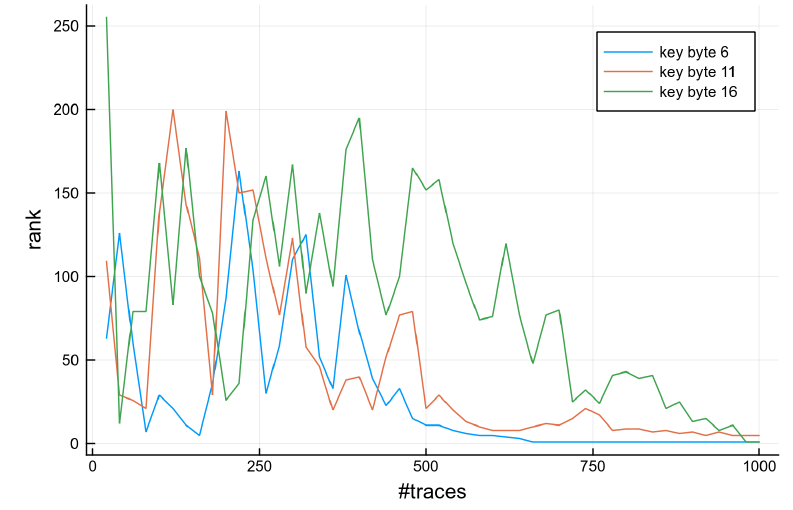
Figure 8: Key rank evolution for hardware AES engine FCA